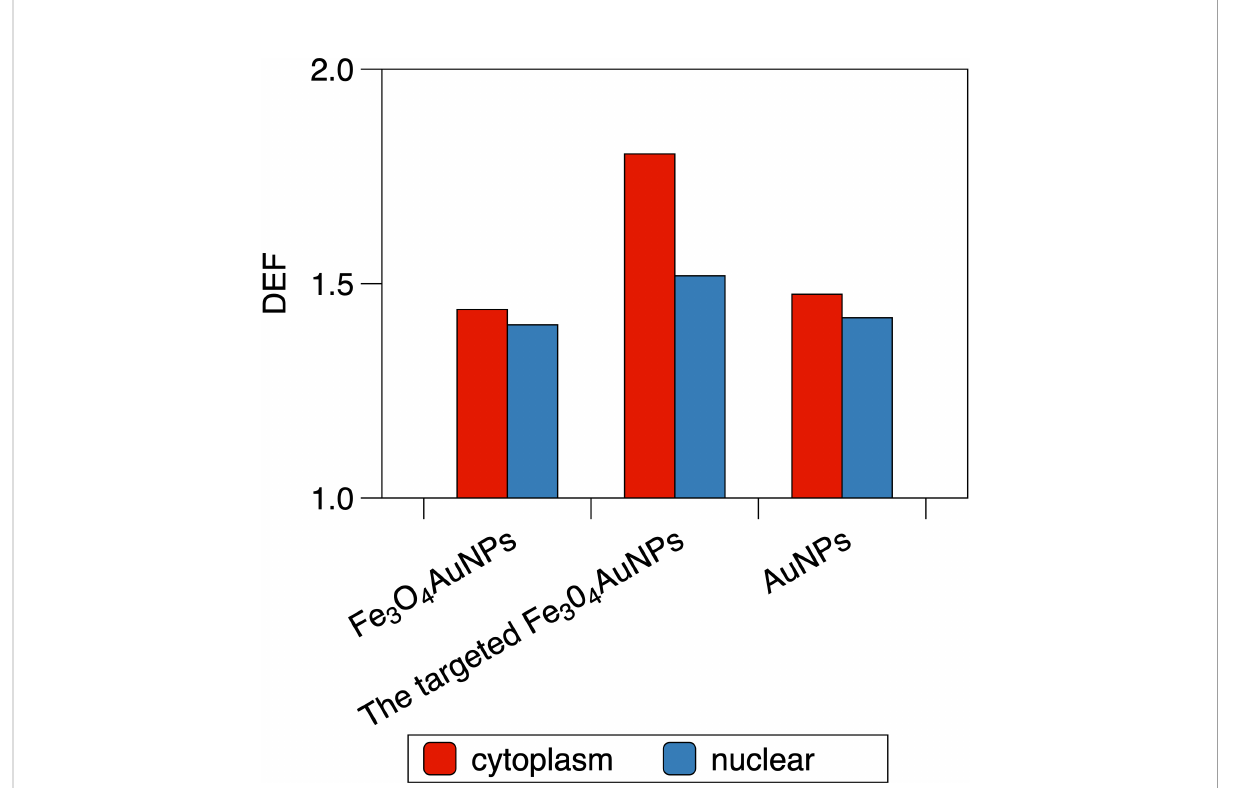
FIGURE 10 The DEF of Fe 3 O 4 @AuNP, the targeted Fe 3 O 4 @AuNP and AuNP in the cytoplasm and the nucleus when irradiated by brachytherapy